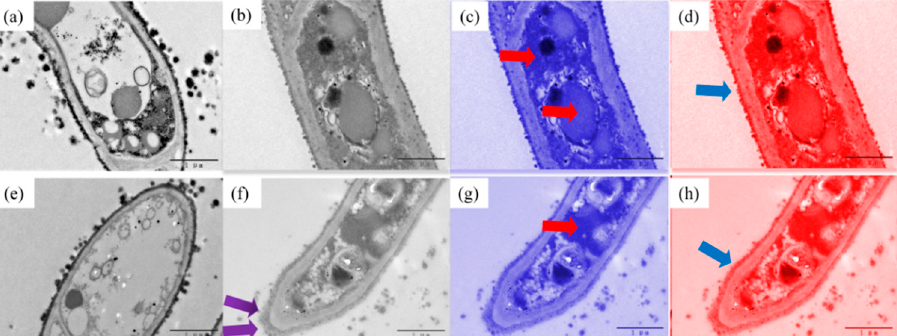
Figure 4. The transmission electron micrograph (TEM) images of mycelia of J45 ( a – d ) and J127 ( e – h ) under 0 and 2 mg/L Cd concentrations (resolution 1 µ m), ( a ) J45 at 0 mg/L Cd concentration, ( b – d ) J45 at 2 mg/L Cd concentration, ( e ) J127 at 0 mg/L Cd concentration, ( f – h ) J127 at 2 mg/L Cd concentration, The blue arrow indicates that the cell wall is thickened, and the red arrow indicates the black shadows also presented in the cytoplasm and vacuoles, the purple arrow indicates the black matter accumulation at the edge of the cell wall.